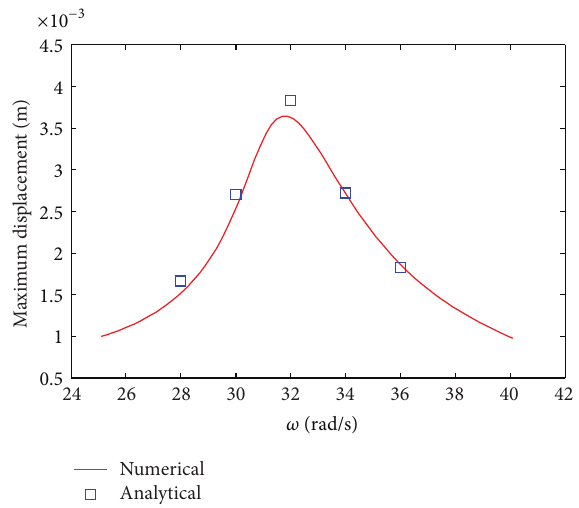
Figure 6: Comparison between the displacement amplitudes from approximation analysis and numerical method.